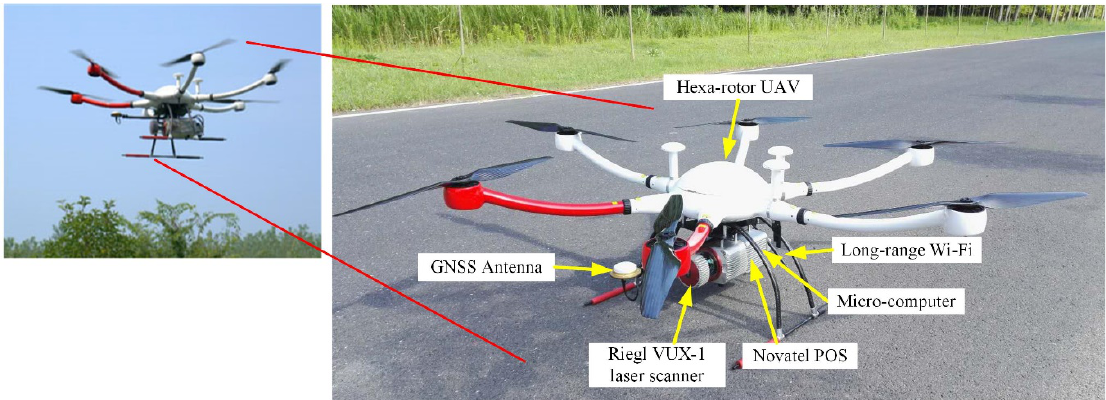
Figure 3. System description of the commercial unmanned aerial vehicle laser scanning (ULS).